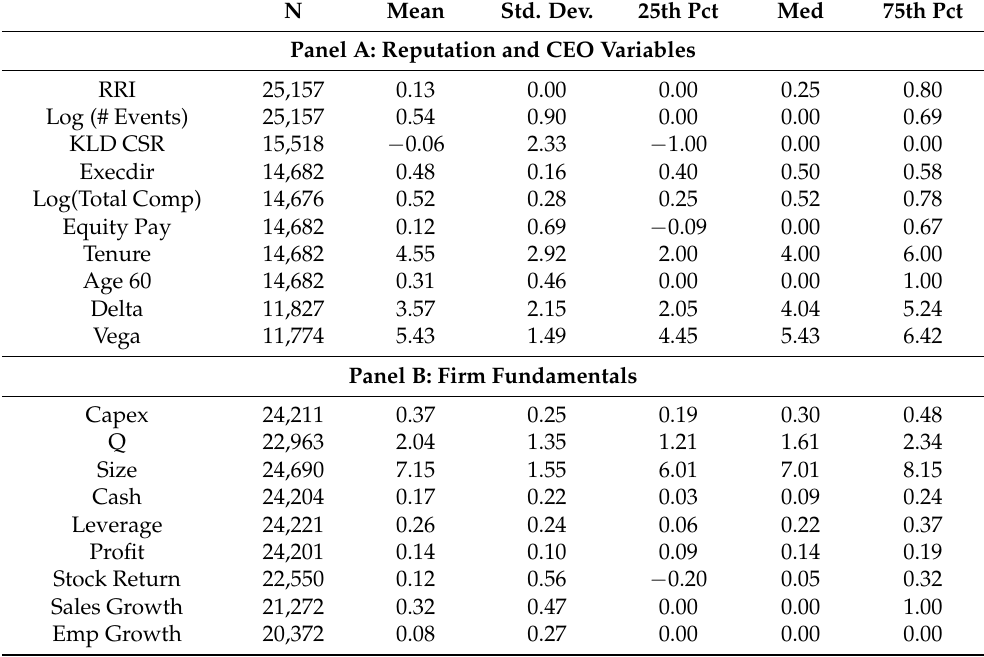
Table 1. Summary Statistics. This table presents summary statistics for the main variables of interest. See Appendix A for variable definitions. All financial variables are constructed using Compustat and are Winsorized at the 1% level at both